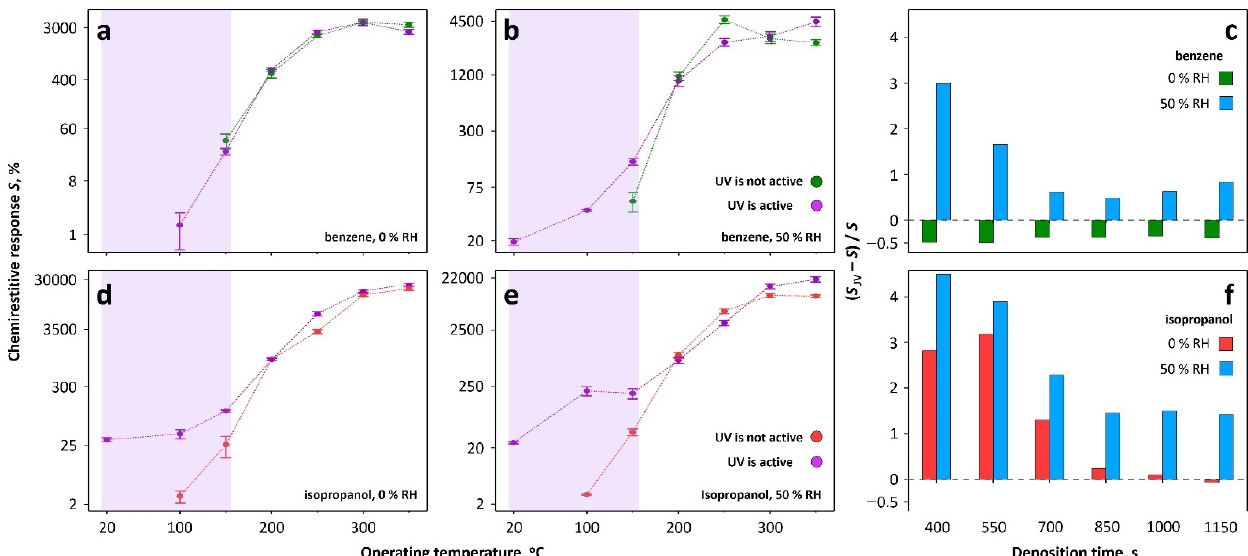
Figure 5. The temperature dependence of chemiresistive response to benzene ( a – c ) and isopropanol ( d – f ), 100 ppm, mixed with dry ( a , d ) and wet, 50 rel. % ( b , e ), air; the data are given for the segments deposited for t = 550 as an example. The diagrams ( c , f ) show the relative difference of the chemiresistive response, S uv , observed to the analytes ( c —benzene, f — isopropanol) at 150 °C and UV radiation and the same response, S , observed without UV distributed over the chip with local areas deposited for various time, 400–1150 s.